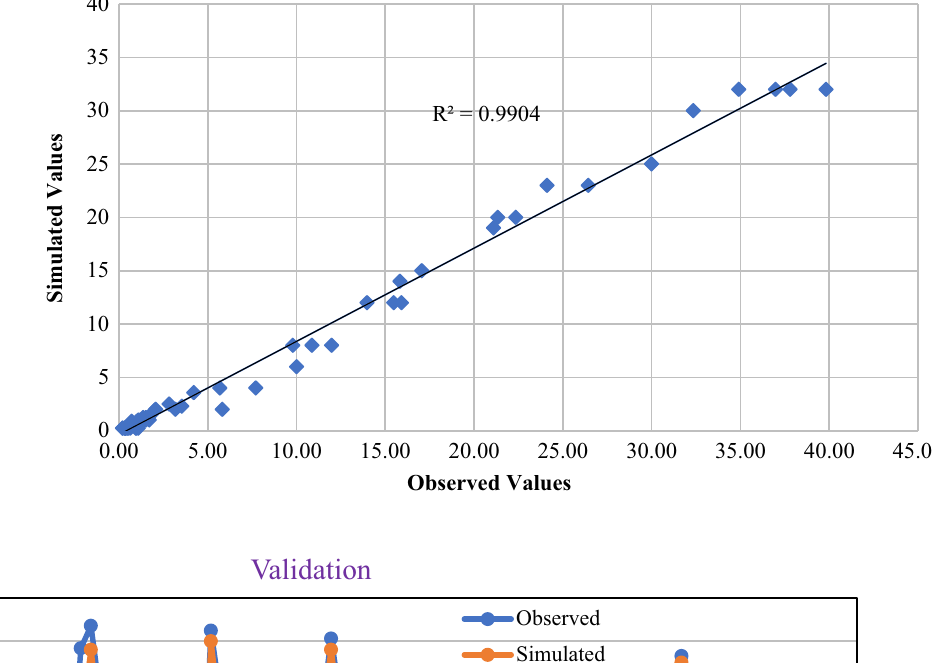
Fig. 12 Scatters plot of observed vs. simulated flow for calibration (2000–2004)